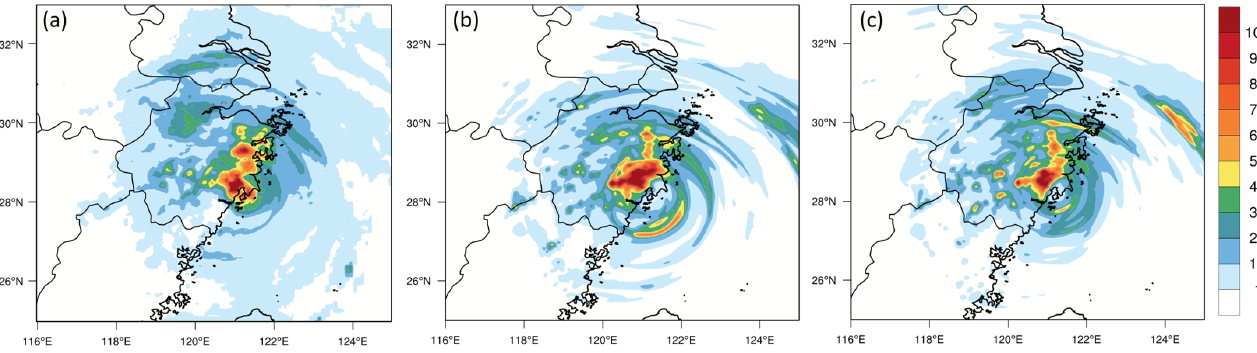
Figure 6. The 3 h accumulated precipitation from 1800 UTC 2100 UTC on 9 August for ( a ) observa- tions, ( b ) CNTL, ( c ) Z-DA. tions, ( b ) CNTL, ( c )